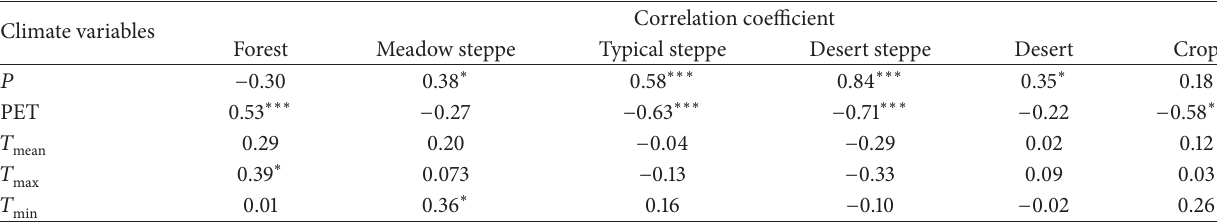
Table 1: Correlation between growing season NDVI and corresponding climate variables for different biomes: growing season 𝑃 , growing , 𝑇 max , and 𝑇 min . season PET, and growing season 𝑇 mean Correlation coefficient Climate variables Forest Meadow steppe Typical steppe Desert steppe